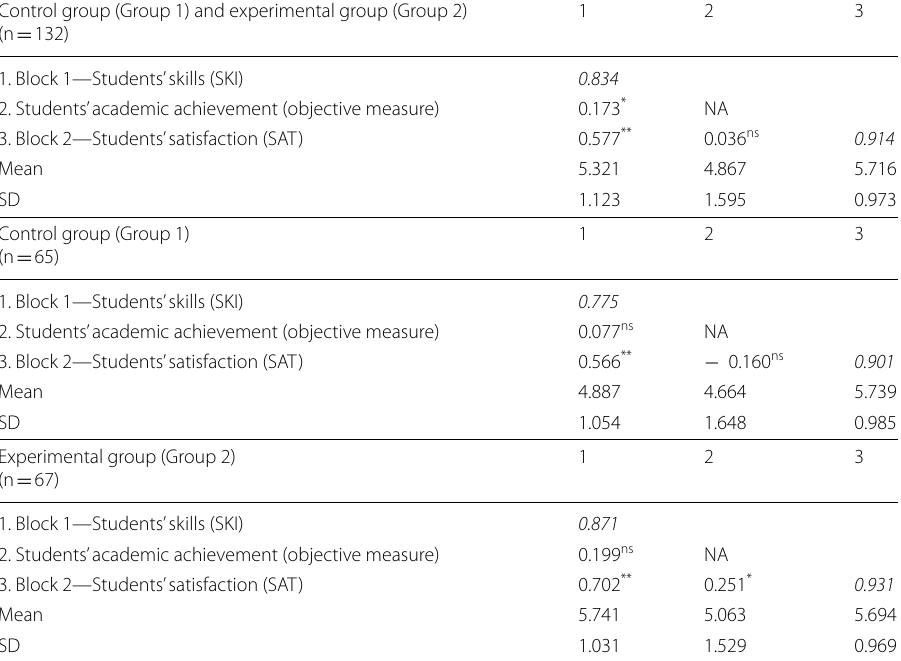
Table 5 Descriptive statistics and